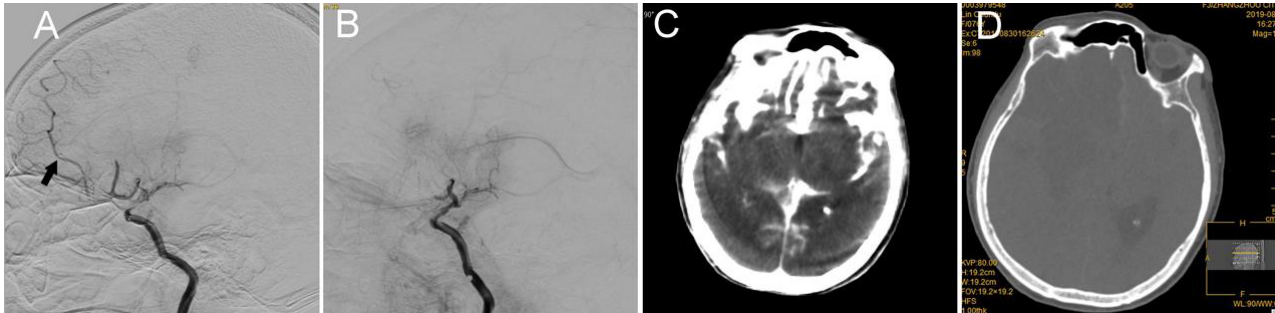
Figure 5. ( A ) Vessel perforation occurred when attempting to advance the microcatheter into A3; the microcatheter was in the parenchyma (the black arrow indicates the tip of the microcatheter). DSA shows the occlusion of the A2 segment of the left anterior cerebral artery. ( B ) This ruptured vessel was immediately sealed with 2 mL of thrombin (total dose was 300 u). ( C ) C-arm CT showed hyperdensity in the cisterna ambiens and sylvian cisterna. ( D ) Post-procedure dual-energy CT showed bilateral frontal lobe infarction without new hemorrhage or brain edema.